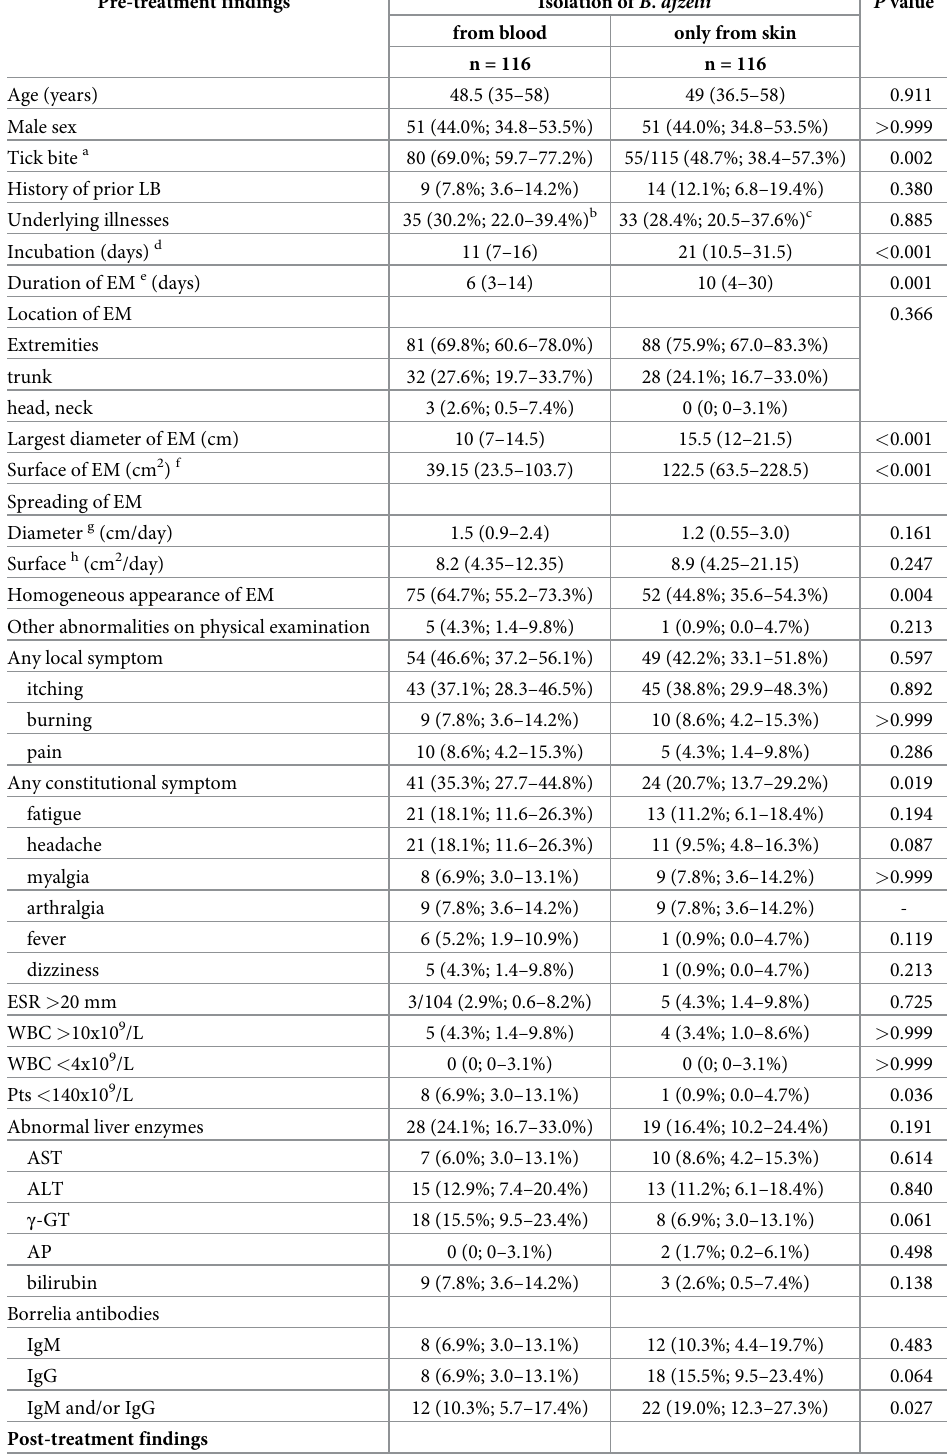
Table 2. Comparison of demographic, clinical, laboratory and microbiological findings according to isolation of Borrelia afzelii from blood or only from